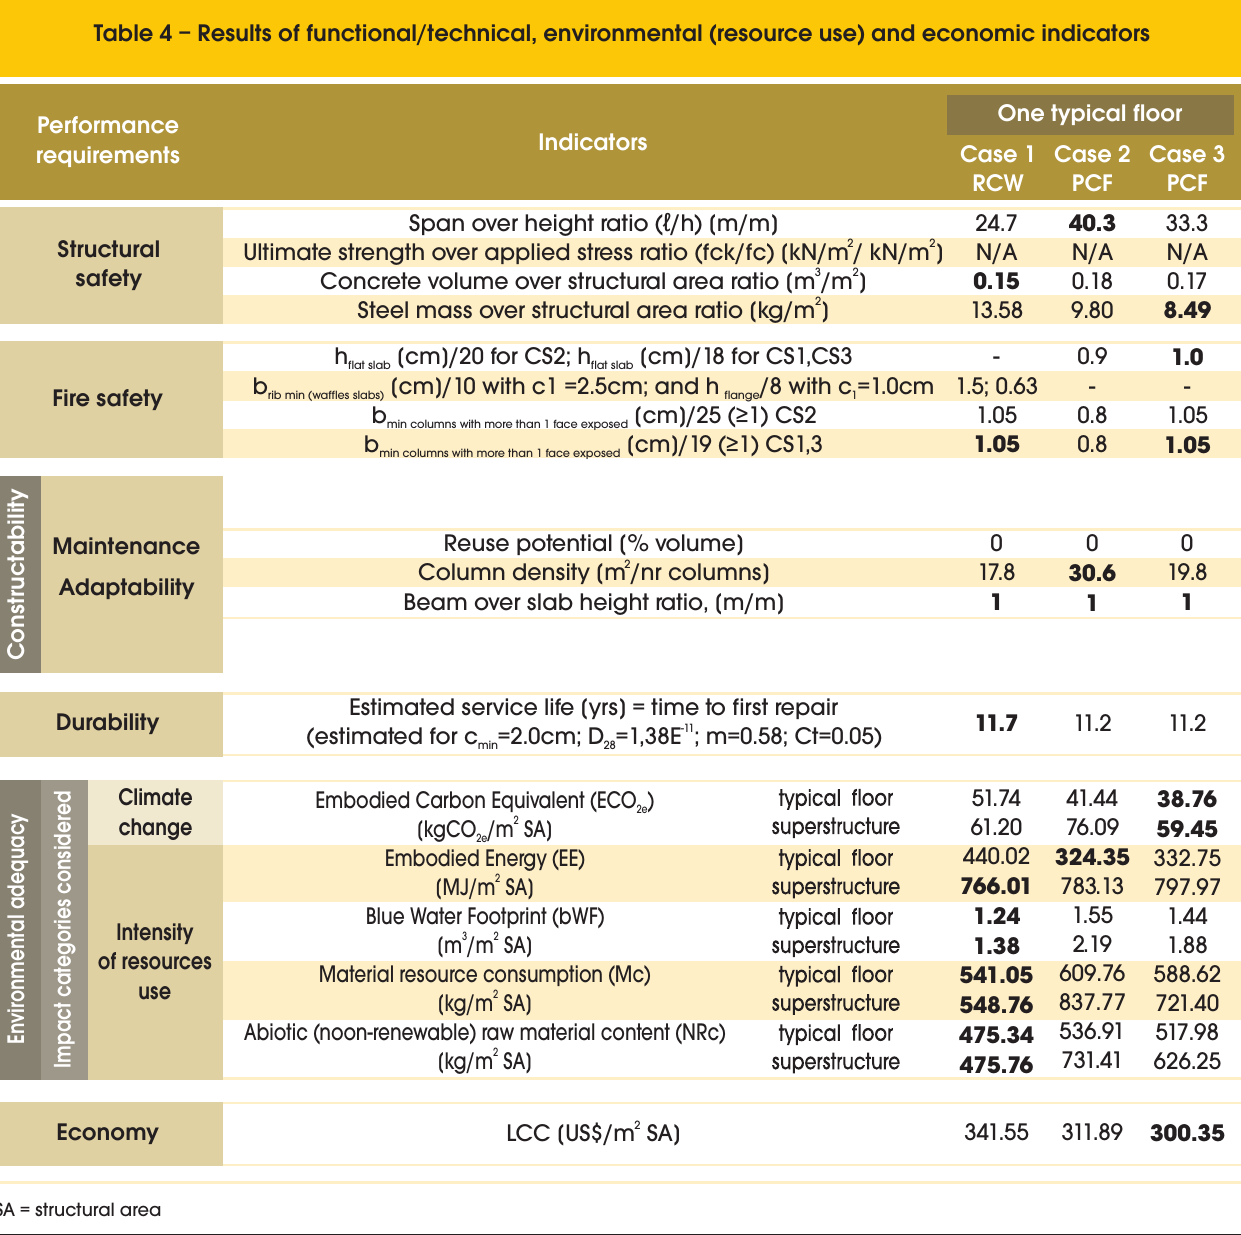
Table 4 – Results of functional/technical, environmental (resource use) and economic